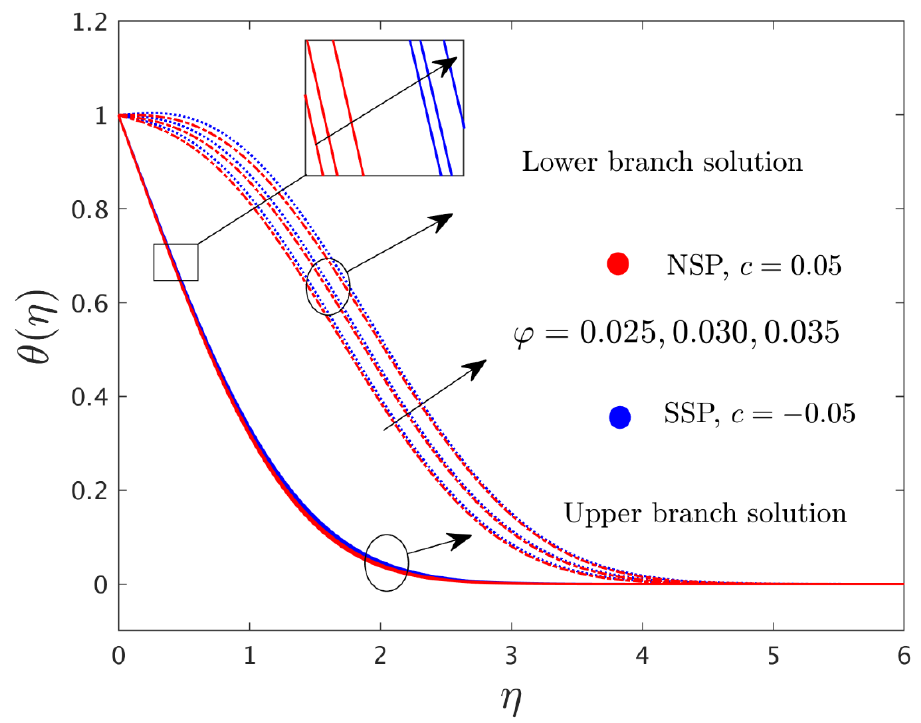
( η ) for varying ϕ